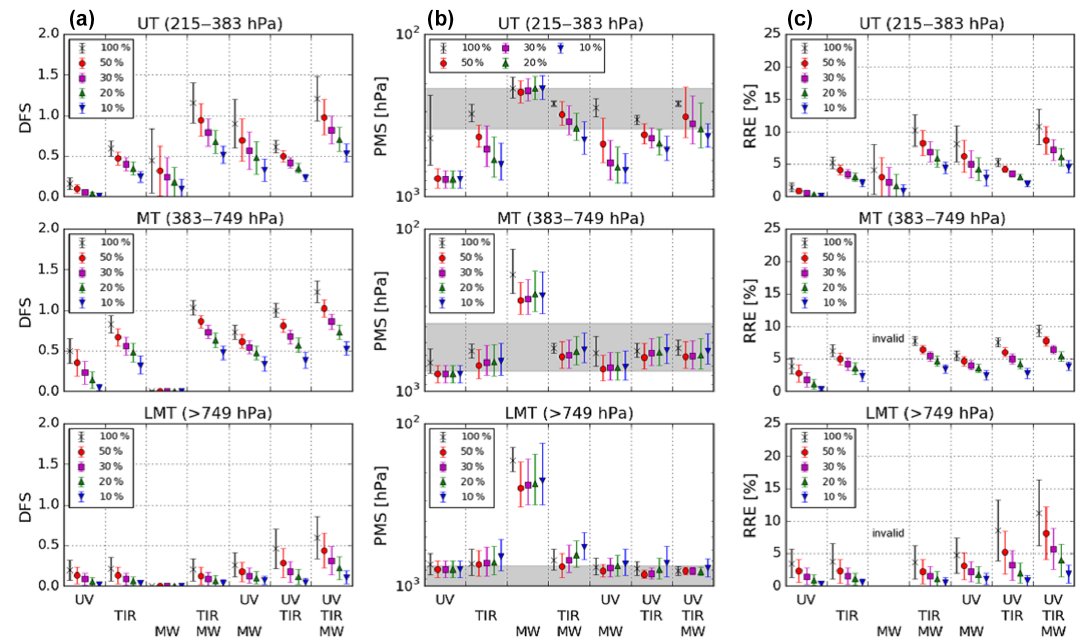
Figure 7. Values of DFS (a) , PMS (b) , and RRE (c) for upper troposphere (UT, 215–383hPa), middle troposphere (MT, 383–749hPa), and lowermost troposphere (LMT, > 749hPa) for 20 profiles averaged: σ a values of 100% (black), 50% (red), 30% (purple), 20% (green), and 10% (blue) of the log-based a priori